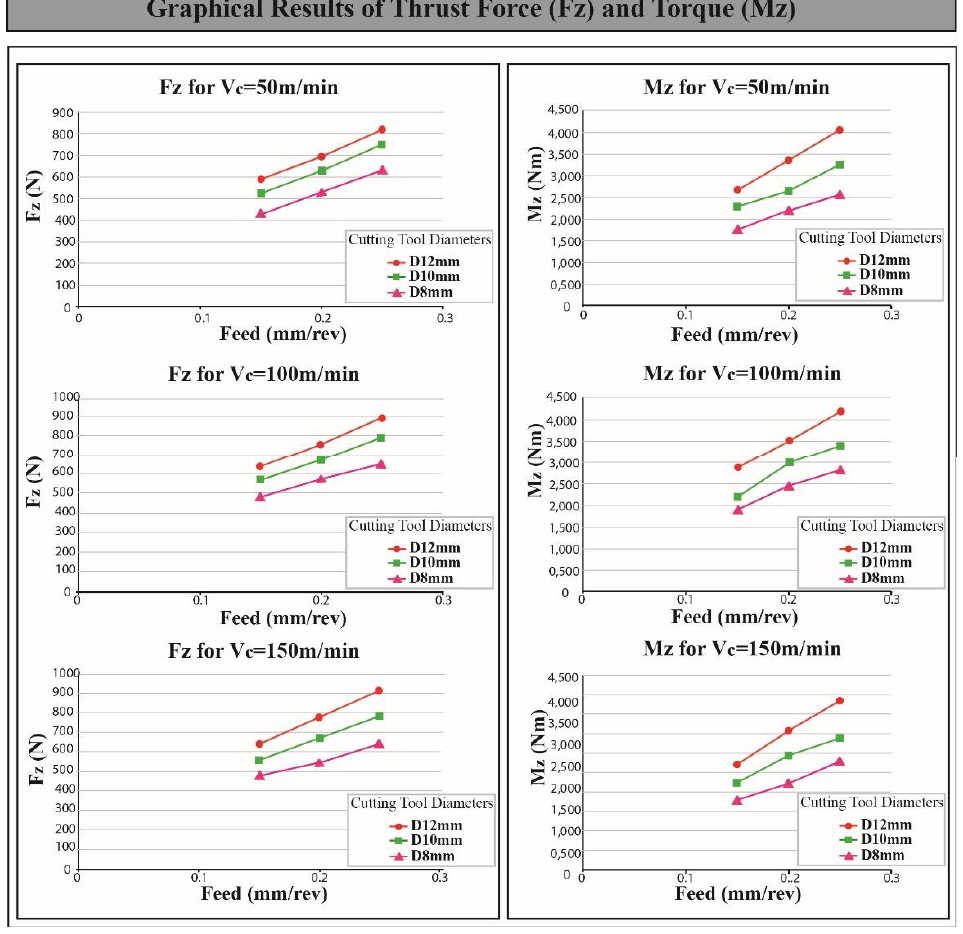
Figure 4. Experimental values derived from Kistler 9123.